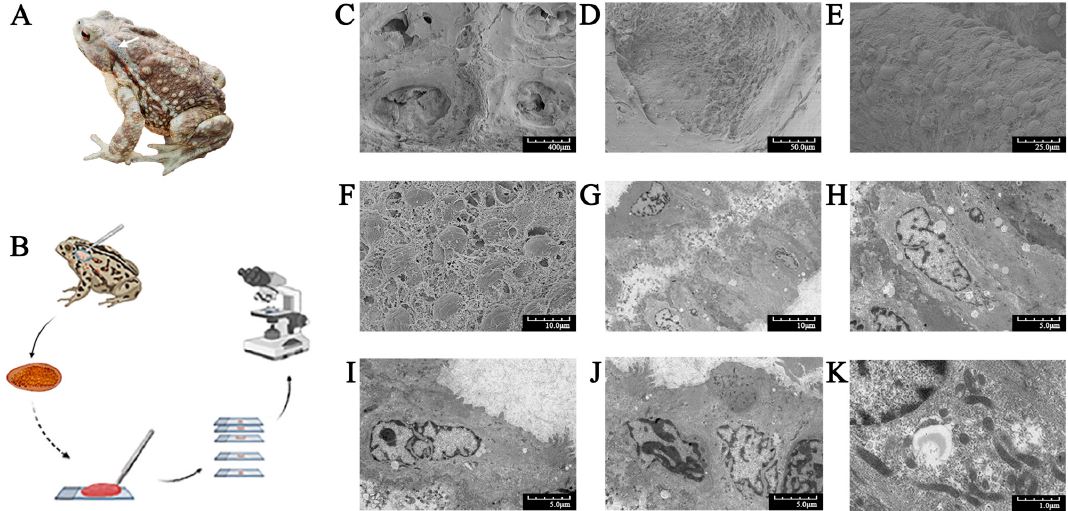
Figure 1. Morphology of Bufo gargarizans and electron microscopy of its ear-side glands. ( A ) Dorsal view of an adult specimen. The white arrow indicates the ear-side gland. ( B ) The process of collecting glands, making slides, and microscopic observation. ( C ) The honeycomb-like structure of a gland. ( D ) A poison gland containing large poison granules. ( E ) Poison granules immersed in the syncytial cytoplasm matrix. ( F ) Poison granules with shrunken surfaces and syncytial cytoplasm matrix with a spongy appearance. ( G ) A monolayer of acini cells around a characteristic central lumen. ( H – J ) A monolayer of secretory cells. There was no clear boundary between the cells, and the nuclei were obvious, with clear edges and folds. ( K ) The syncytial cytoplasm matrix containing high numbers of organelles. Scanning electron microscopy ( C – F ). Transmission electron microscopy ( G – K ).